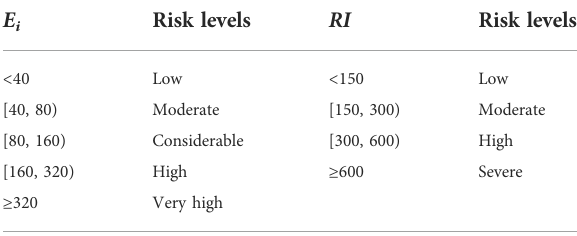
TABLE 1 Classi fi cation of potential ecological risk factors ( E i ) and risk index ( RI